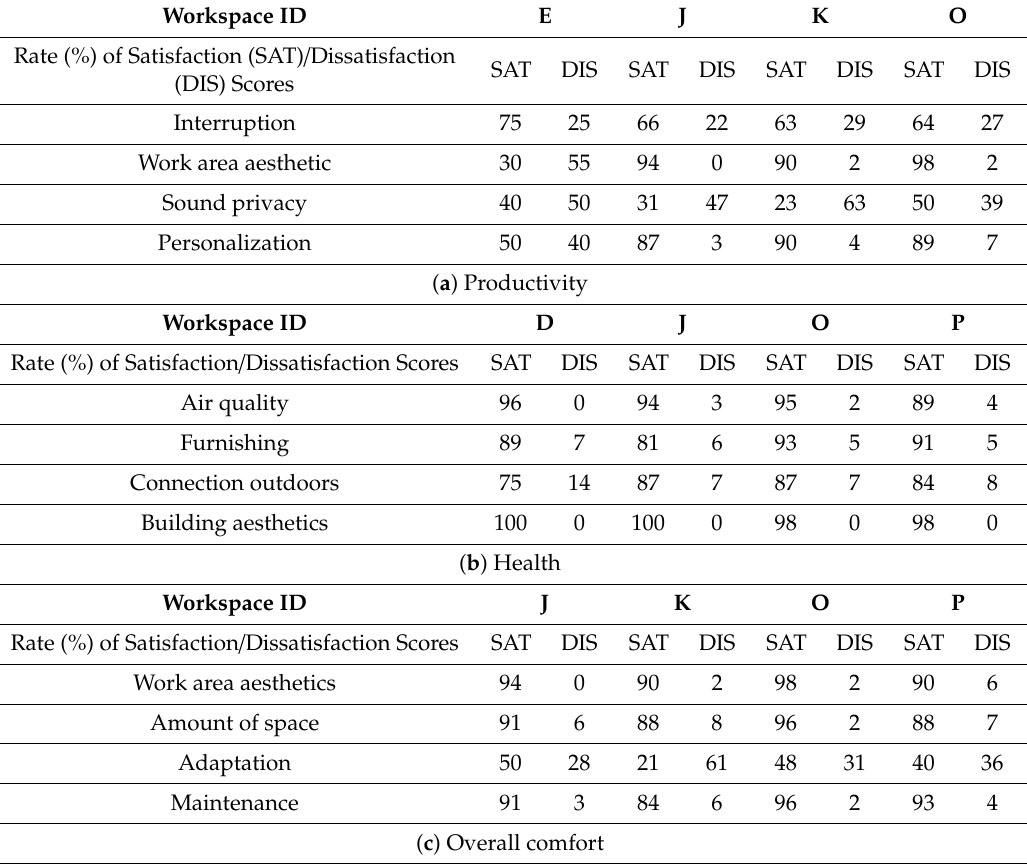
Table 6. Rate of satisfaction and dissatisfaction scores for ( a ) perceived productivity, ( b ) health, and ( c ) overall comfort work area.